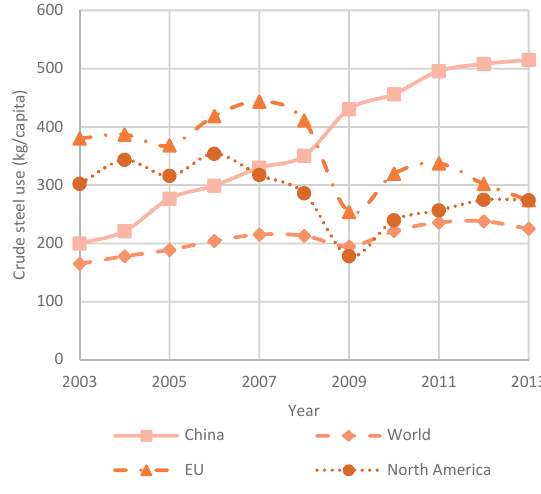
Figure 2. Graph of the apparent crude steel usage per capita of major nations